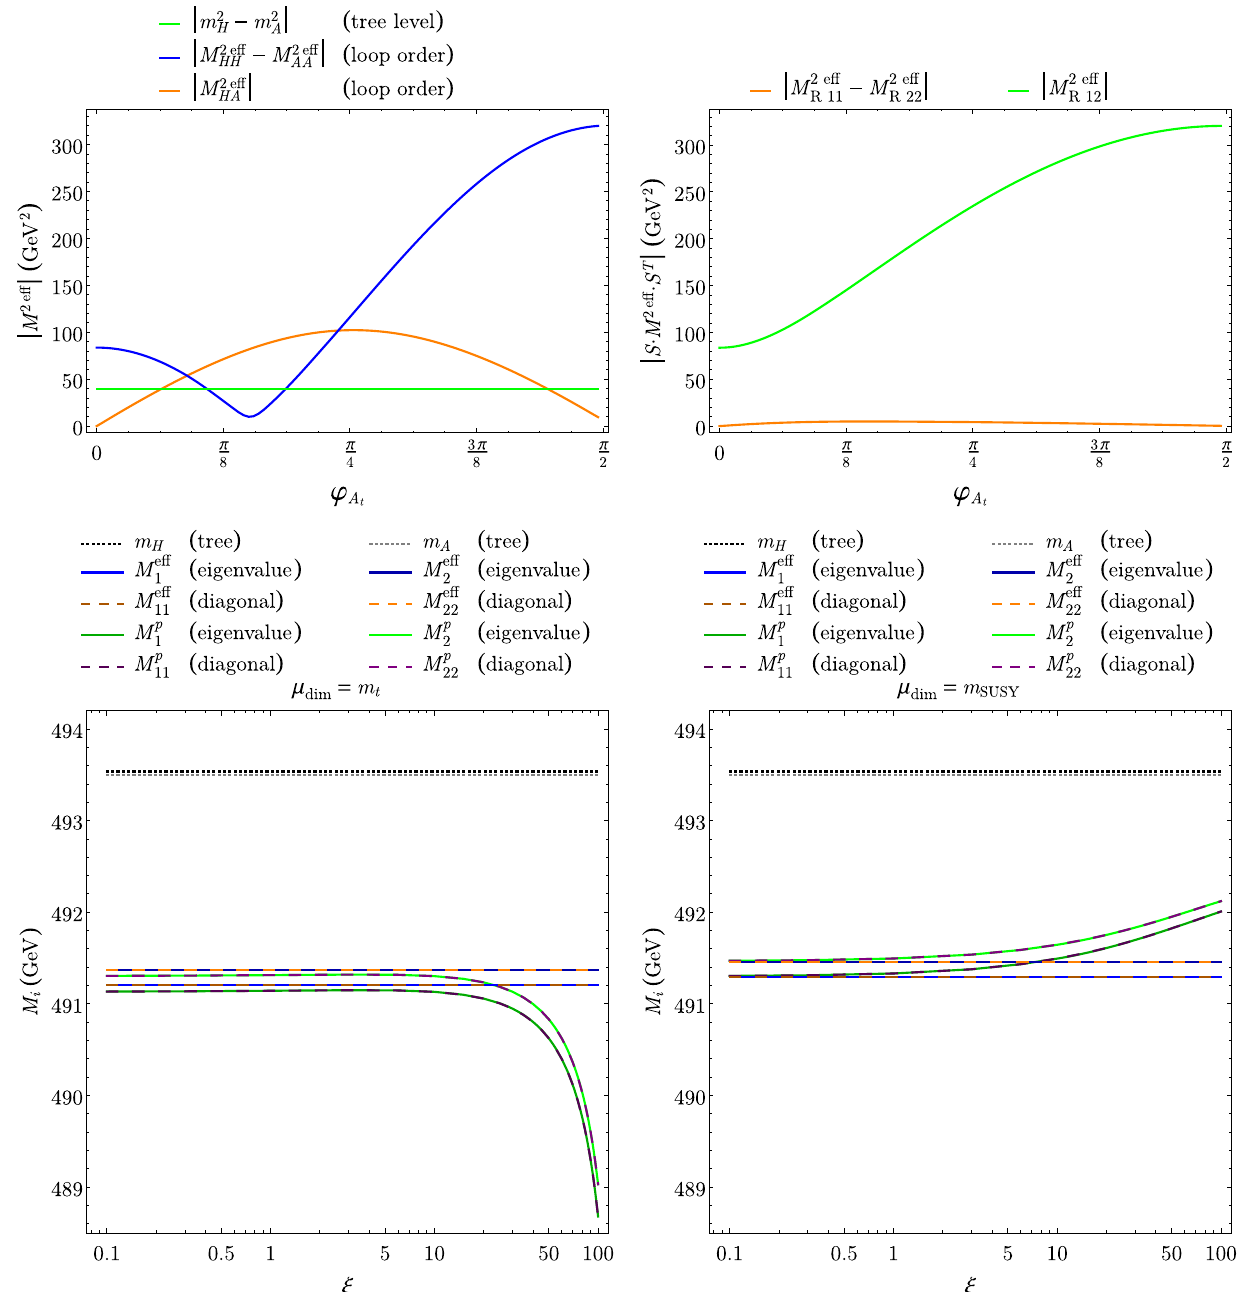
Fig. 4 The mass determination is illustrated in the MSSM for the effective mass matrix being complex, it cannot be fully diagonalized degenerate ( H , A ) pair with CP -violation. t β = 30, M H ± = 0 . 5TeV, by a real orthogonal matrix, but the off-diagonal element can be min- (cid:23) (cid:24) ∈ m SUSY = 1TeV, A t = 3TeV, ϕ A 0 , π (upper row), then imized. Lower left: the mass determination is shown for ϕ A 2 t μ = m = 3 π ≈ 0 . 47. Upper left: The mass-splitting vs. mixing is shown: ϕ t : the tree-level masses are shown in dotted gray and black; dim A t 20 theeigenvaluesoftheeffectivemassmatrixareshowninshadesofblue; in green, the mass-splitting between the CP -even and CP -odd heavy the diagonal elements of the rotated effective mass matrix are shown in scalars at the tree level; in blue, the mass-splitting between the two dashedbrown/orange;thepolesretainingfullmomentumdependencein diagonal entries of the effective mass matrix, as defined in Eq.(12); in theMSSMself-energiesareshowningreen;thecorrespondingdiagonal orange, the mixing term of Eq.(12) (in absolute value). Upper right: elements after rotation are shown in purple. Eigenvalues and diagonal The mass-splitting vs. mixing is shown after rotation by an appropri- elements after rotation essentially coincide, resulting in pairs of curves ate real orthogonal matrix: in green, the splitting between the diagonal = S · M 2eff · S T ; overlapping each other. Lower right: the mass determination is shown elements of the rotated effective mass matrix M 2eff R = 3 π for ϕ A , μ dim = m SUSY (identical color in orange, the magnitude of the subsisting off-diagonal element – the 20 t